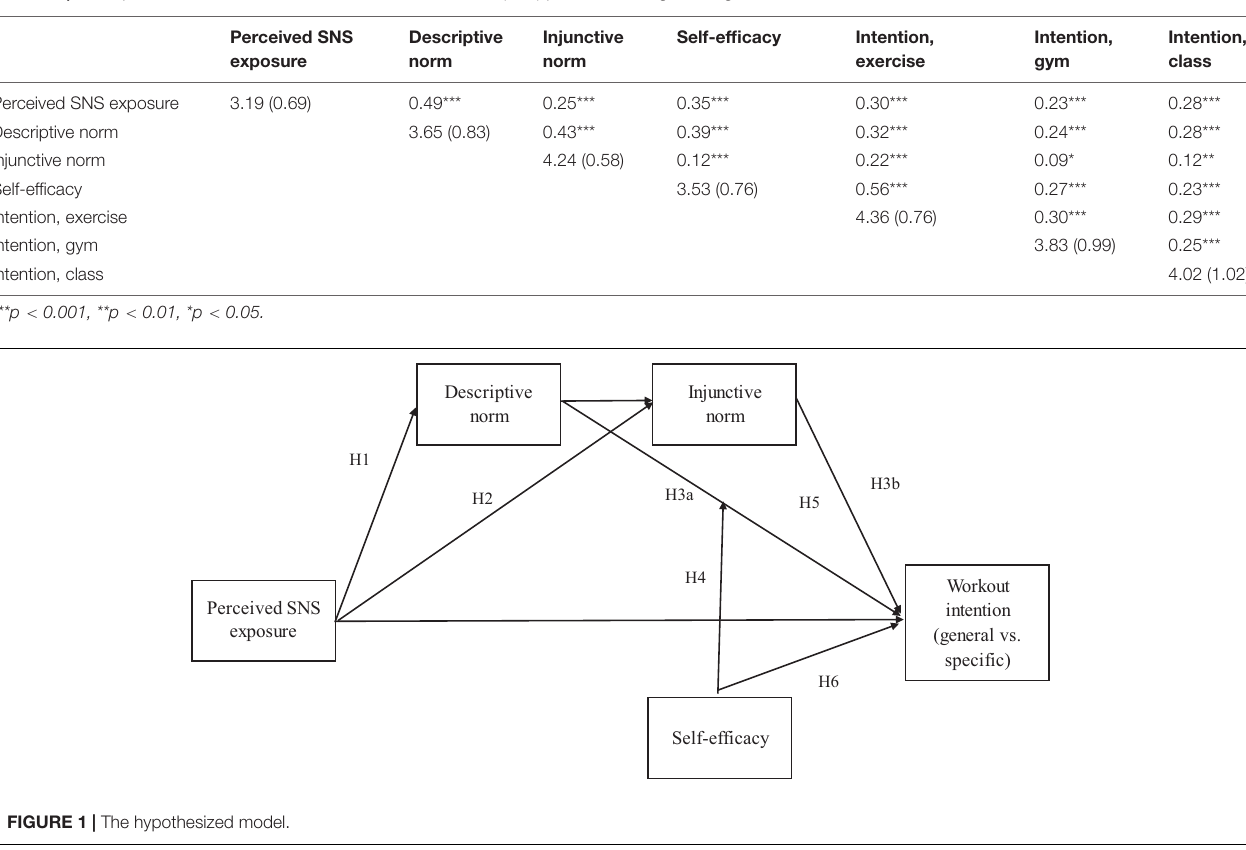
Figure 2 ). The result of the simple effect test was different from